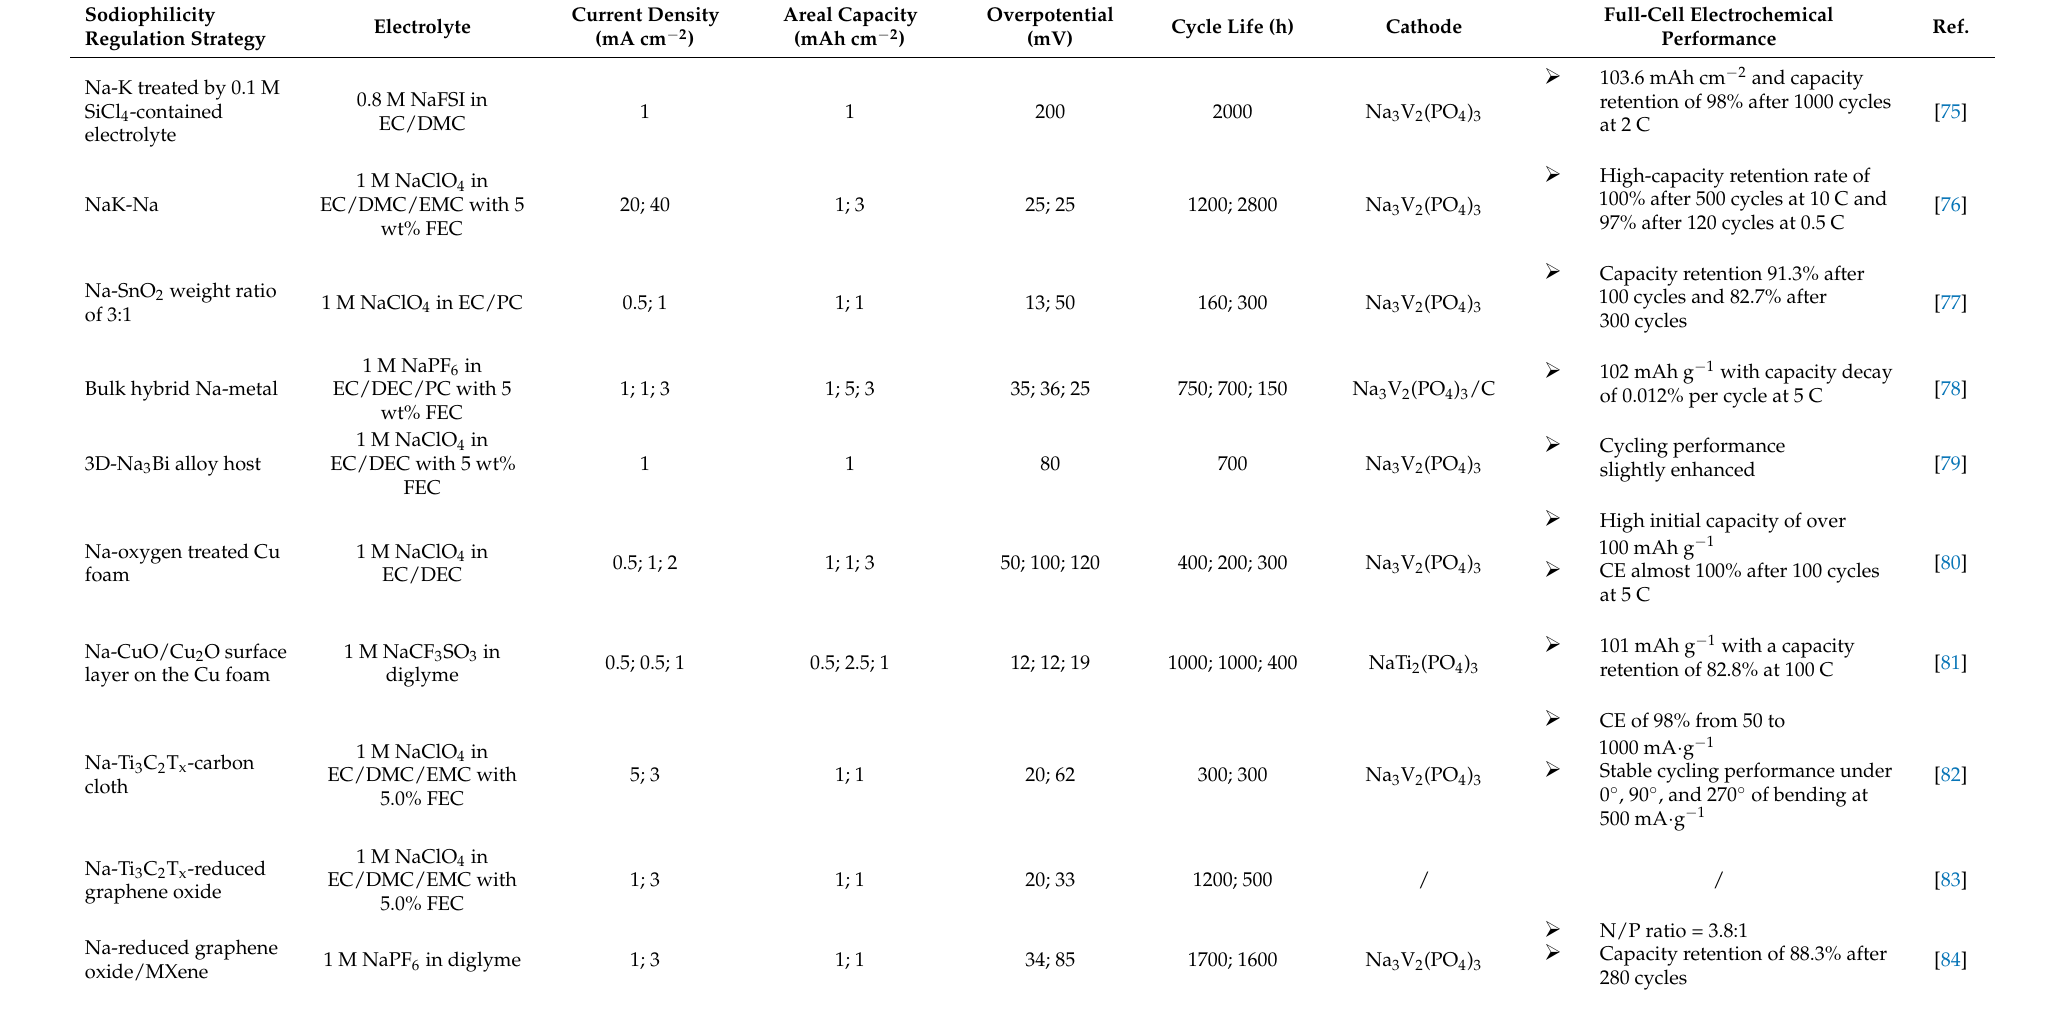
Table 2. Comparison of electrochemical performance of Na metal anodes modified by different wet- tability-enhancing strategies.